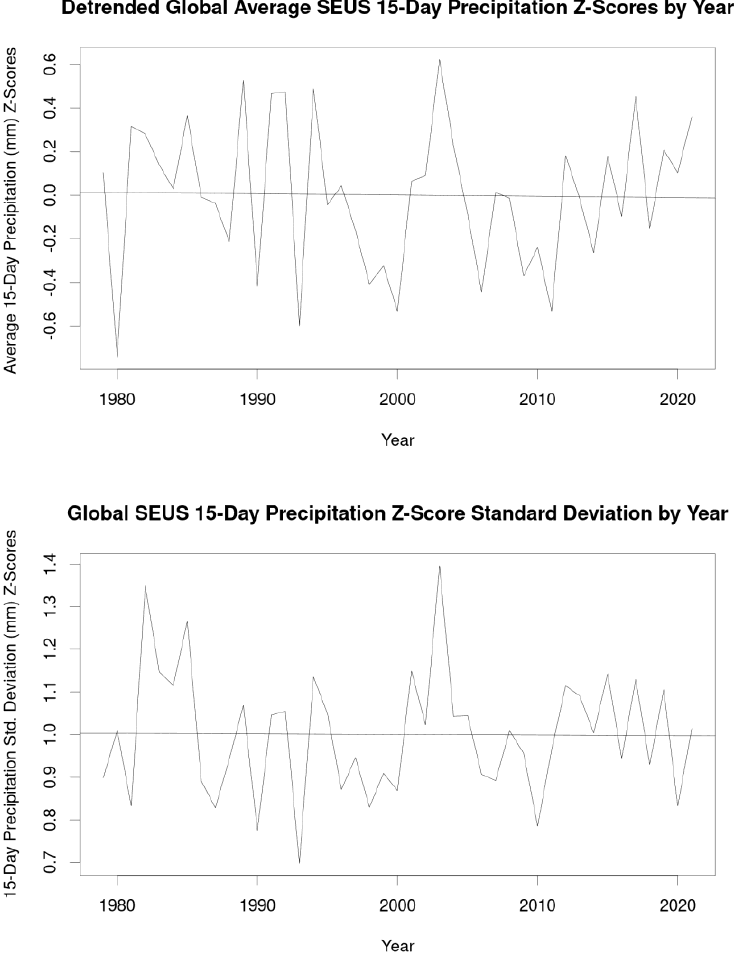
Figure 4. Same as Figure 3, but for the detrended z -scores of precipitation mean ( top panel) and standard deviation ( bottom panel). Note that both trends are now nonsignificant ( p = 0.93 for the means, p = 0.91 for the standard deviations).